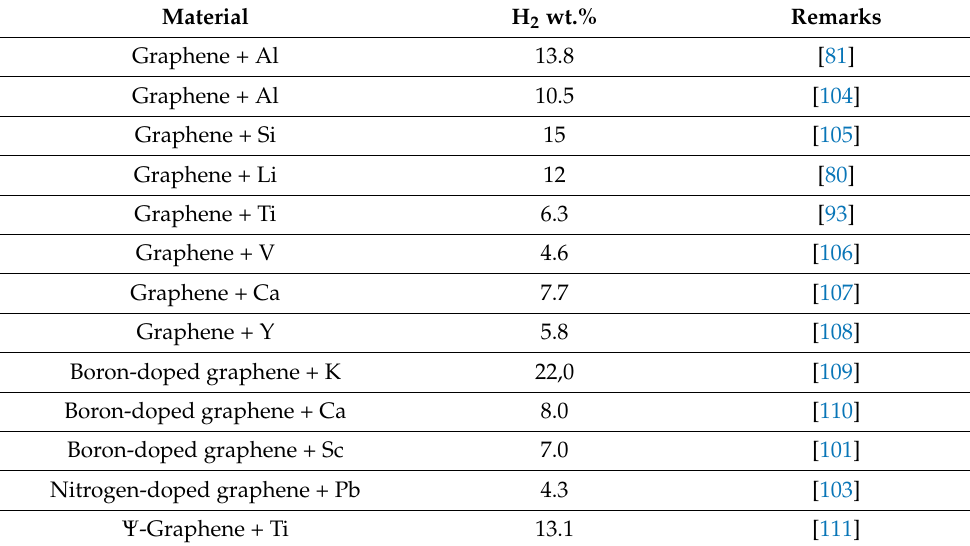
Table 2. Hydrogen storage by decorated graphene—results of computer analyses. Material H 2